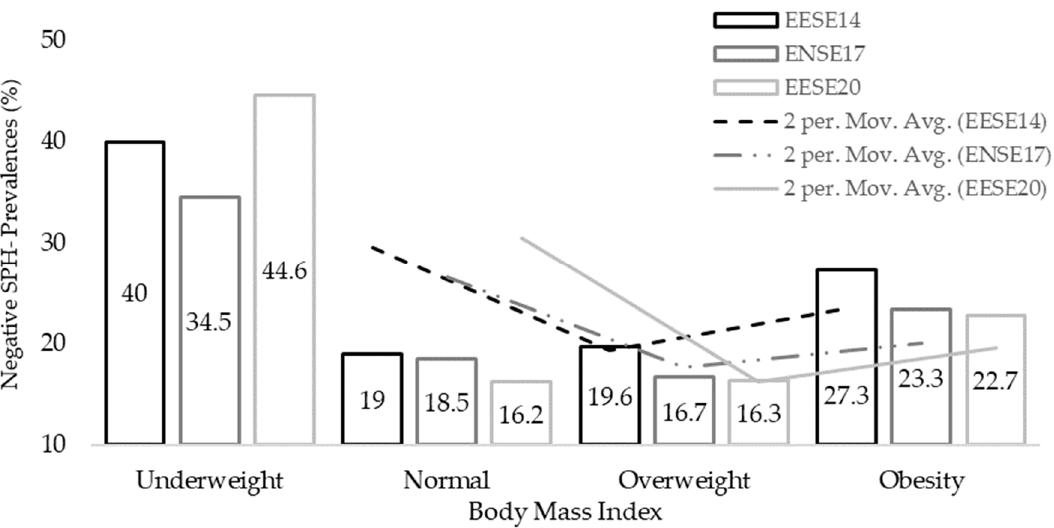
Figure 2. Negative Self-Perceived Health (SPH) prevalence according to the Body Mass Index (BMI) in the Spanish population in the three surveys EESE2014, ENSE2017, and EESE2020. Figure 3 shows the Positive SPH prevalence in the BMI Group for the three surveys. Opposite to the Negative SPH data, it was lower in the Underweight than in Normal-weight and Overweight groups ( p < 0.05) (Table S4).